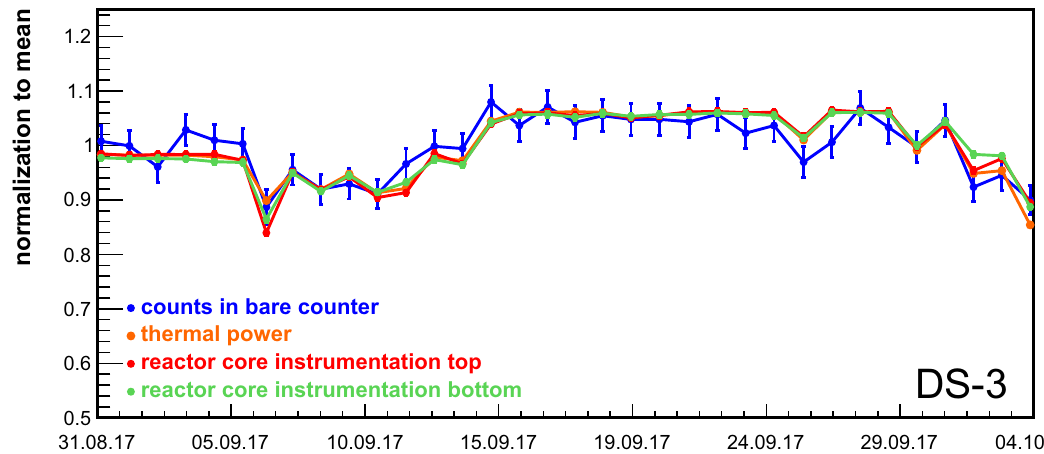
Fig. 16 DS-3 at the beginning of a reactor cycle; counts in bare BSS compared to the thermal power and the core instrumentation